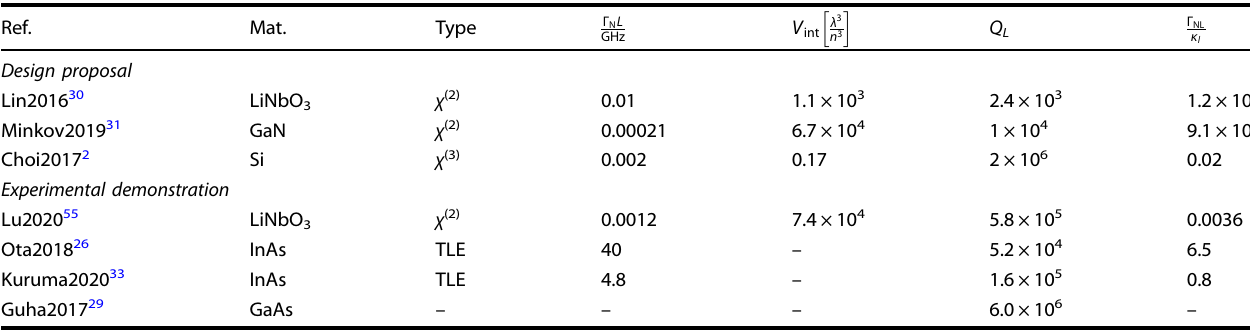
Fig. 9 Gate error as a function of the ratio between nonlinear coupling rate and linear loss rate. Calculated for the three types of nonlinearity we have studied here and in previous work. The generalized nonlinear coupling rate, Γ NL , corresponds to g here and to χ 2 or χ 3 /4 from equation 3 in Ref. 4 . The vertical dotted lines show state of the art 28 and the expected performance by combining g from Ref. 28 and κ l from Ref. 47 (green dot). Note that the fi gure of merit, Γ NL / κ l , for bulk nonlinearities are orders of magnitude smaller than for the TLE and therefore not included in this plot. Table 1. Comparison of nonlinear coupling rates and linear loss